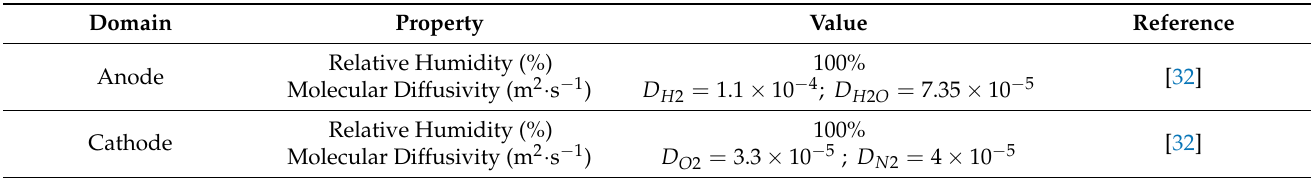
Table 2. Physical properties of cell’s main